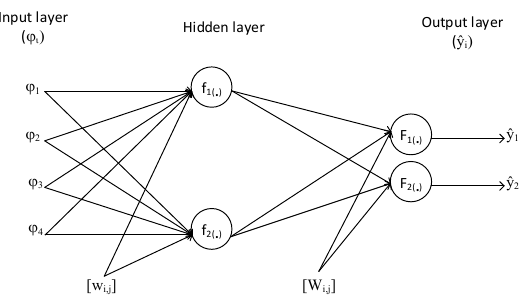
Figure 2. Structure of multilayer perceptron.